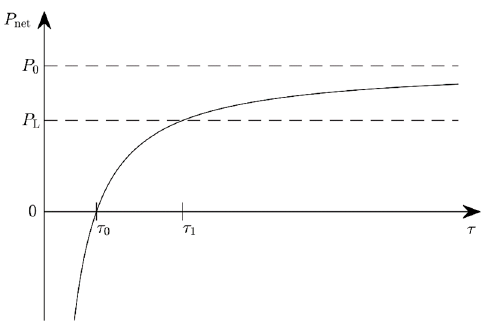
Figure 1. The available power P net for periodic adjustment as a function of the time span τ between adjustment steps.